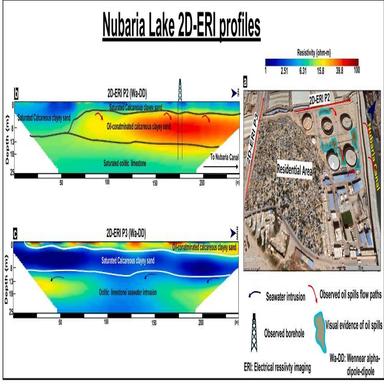
(a) 2D-ERI P2 and P3 at Nubaria Canal showing the oil-contaminated soil and oil leakage flow path towards Nubaria Canal. (b, and c) 2D electrical resistivity models of 2D-ERI P2 and P3 obtained from 2D inversion of combined Wa and DD (Wa-DD) datasets, respectively, applying AIA using a blocky model option (L1-norm inversion) and calibrated with the observed borehole information and RS data.